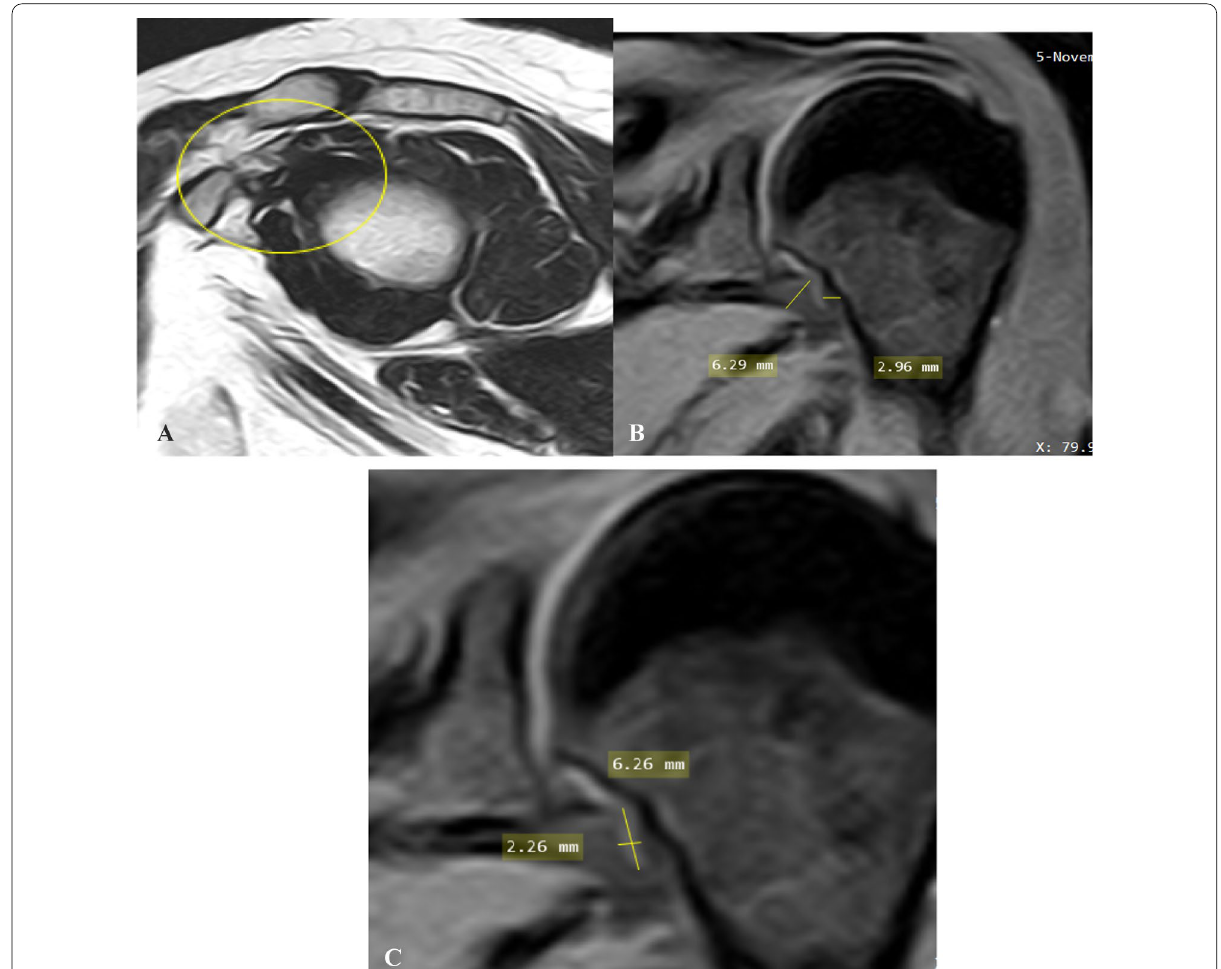
Fig. 3 A Oblique sagittal T2-weighted MR image shows partial obliteration of subcoracoid fat triangle with no observed fat planes or coracohumeral ligament (encircled area). B Oblique coronal fat-suppressed PD-weighted MR image shows maximum capsule thickness at glenoid and humeral portions of axillary recess, the humeral was fibrotic and obliterated. C Oblique coronal fat-suppressed PD-weighted MR image shows measurement of maximal height and width of axillary